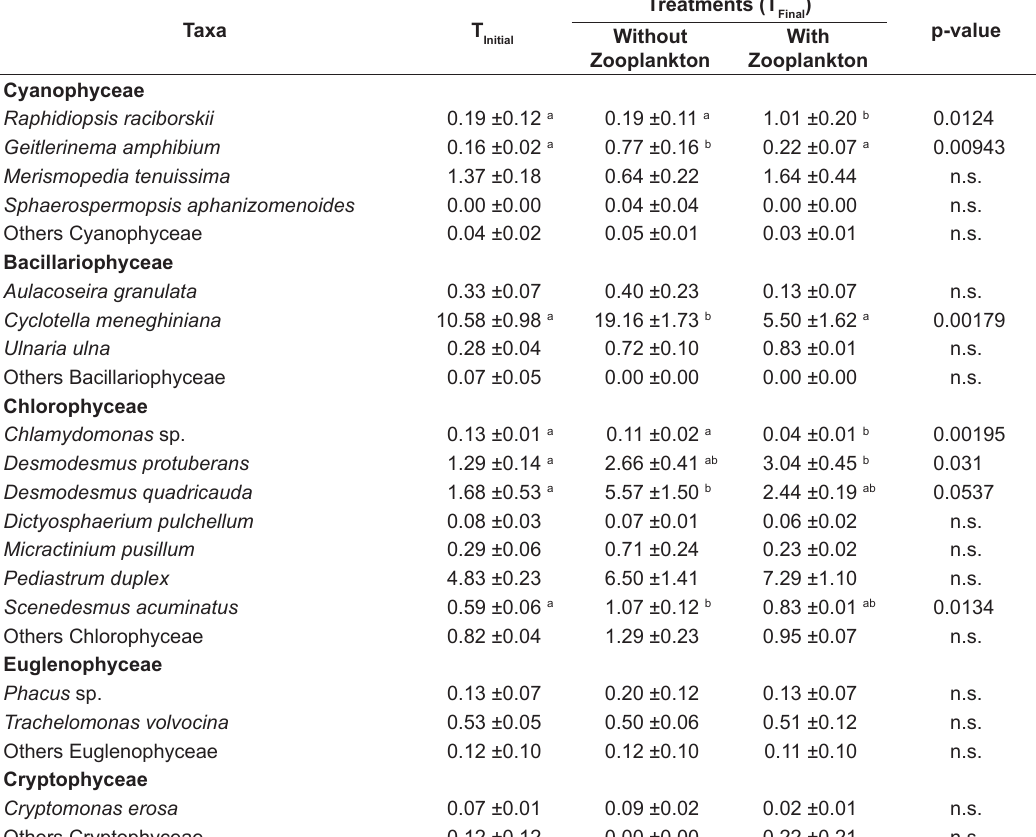
P -values represent statistical results of ANOVA one-way . Different letters indicate significant differences between the means ( p <0.05). “n.s. = no